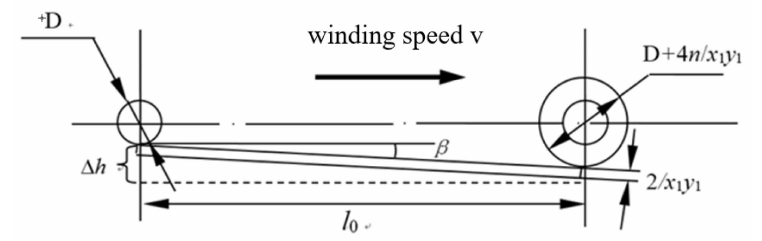
Figure 5. Diameter change of the drive unit winding